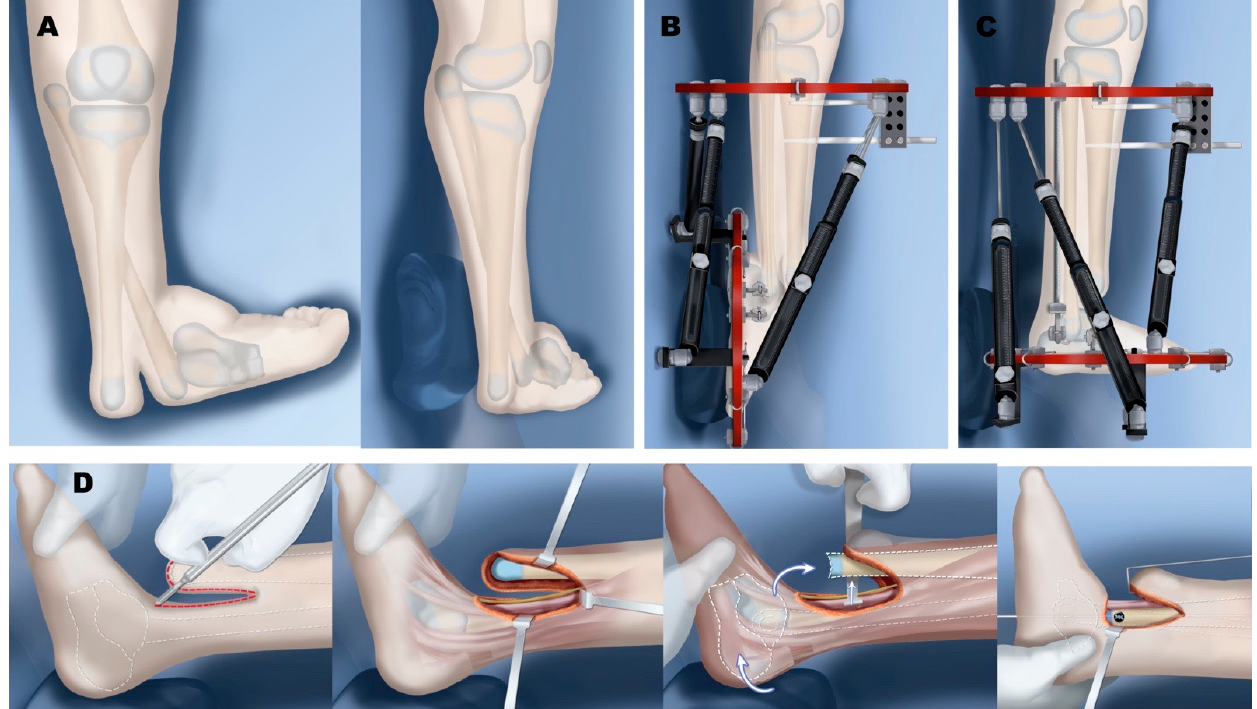
Figure 6. Treatment of Paley type 3A. ( A ) Distal tibia-fibula diastasis. The tibial plafond is absent and the end of the tibia is what normally would have been a medial malleolus; foot and fibula internally rotated around tibia. ( B ) Application of external fixator for gradual correction of foot and fibula position. ( C ) Foot centralized under end of tibia, ready for tibio- talar arthroplasty. ( D ) Distal tibia reshaping to talus and stabilization of distal tibia and fibula diastasis and osteotomy of tibia for diaphyseal straightening. ( E ) Final result after hardware removal with plantigrade foot and distal fibula screw epiphysiodesis.